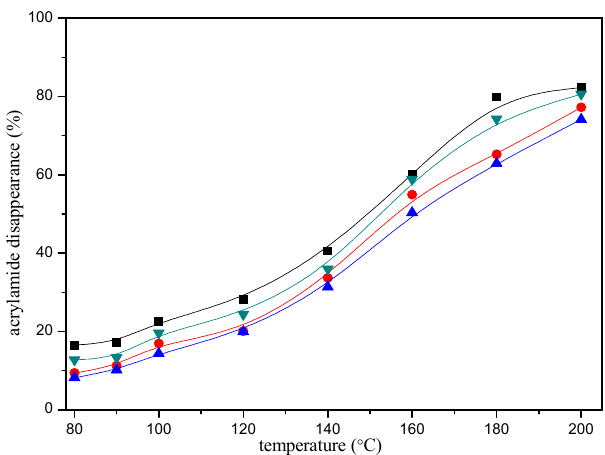
Figure 3. Temperature-response effect of selected mercaptans on the acrylamide disappearance after heating an acrylamide (0.2 μ mol)/ mercaptans (20 μ mol) model system at pH 7 for 10 min. Mercaptans assayed were 1,2-ethanedithiol ( ■ ), 1-butanethiol ( ● ), 2-furanmethanethiol ( ▲ ), and 2-methyl-3-furanthiol ( ▼ ).